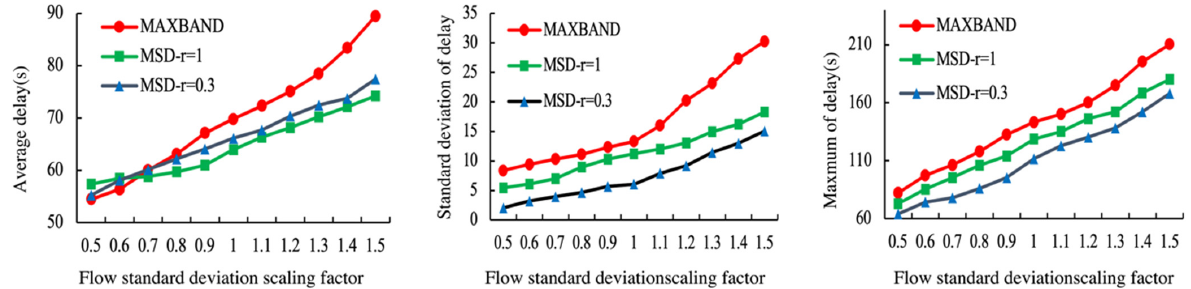
Figure 16. Effect of traffic flow fluctuation on delay index.